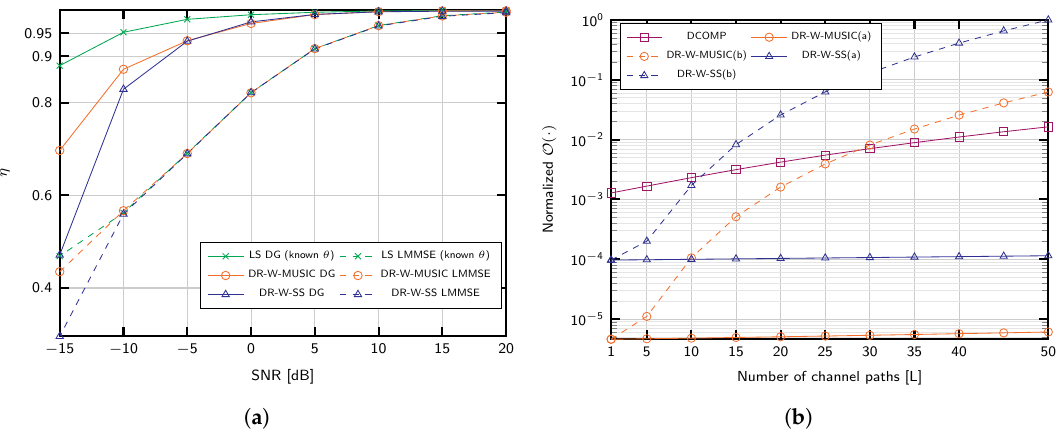
Figure 6. ( a ) efficiency of channel estimation for M = 200 antennas, L = 5 propagation paths, T tr = 25, and K = 100 training periods; ( b ) normalized computational complexity for M = 200 antennas, dictionary size G = 2 M , K = 150 training periods, training length T tr = 50, N c = 64 subcarriers, and different number of